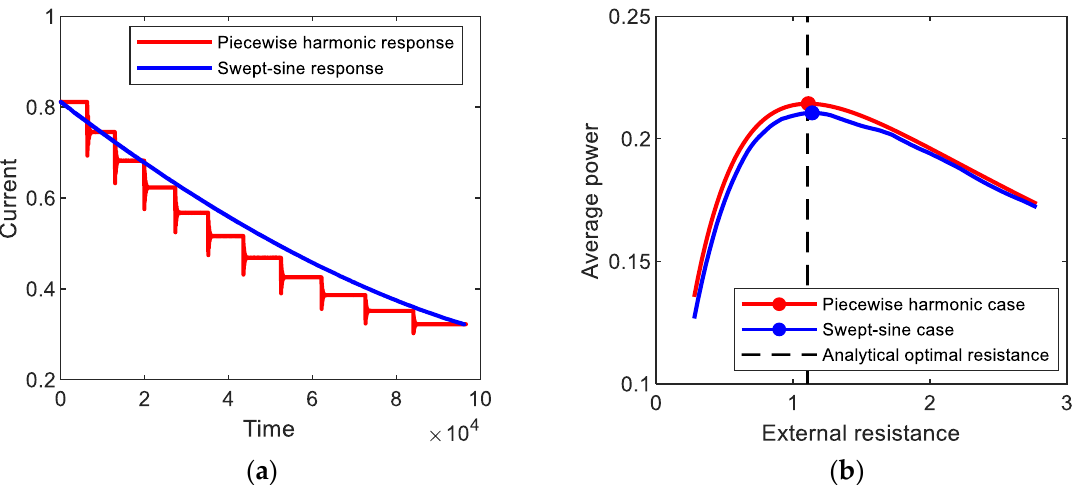
Figure 12. ( a ) Amplitudes of the output current responses to (red line) piecewise harmonic and (blue line) swept-sine excitations, which are obtained for the period-1 T interwell motions of the bi-stable electromagnetic energy harvester, and ( b ) average output powers evaluated with the variation of the external load resistance.